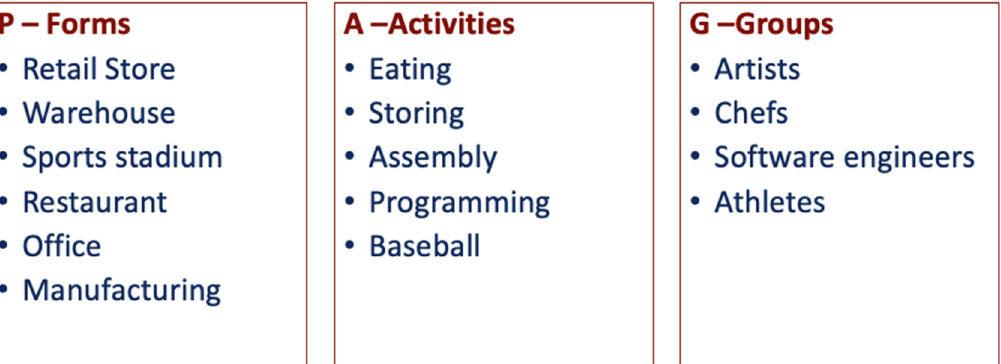
Figure 2. Example elements for each component.